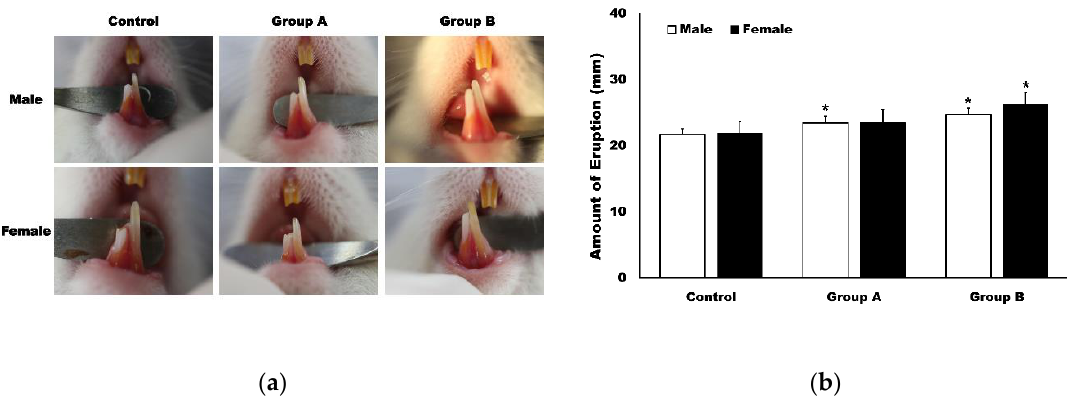
Figure 2. Results of tooth eruption study. ( a ) Representative findings after 4HR administration. Administration of 4HR increased the rate of incisor eruption. ( b ) Cumulative amount of incisor eruption. Compared to the control, the high-dosage group (Group B) showed statistically significant difference (* p < 0.05). In the case of the low-dosage group (Group A), only the male group showed statistically significant difference compared to the control (* p < 0.05).